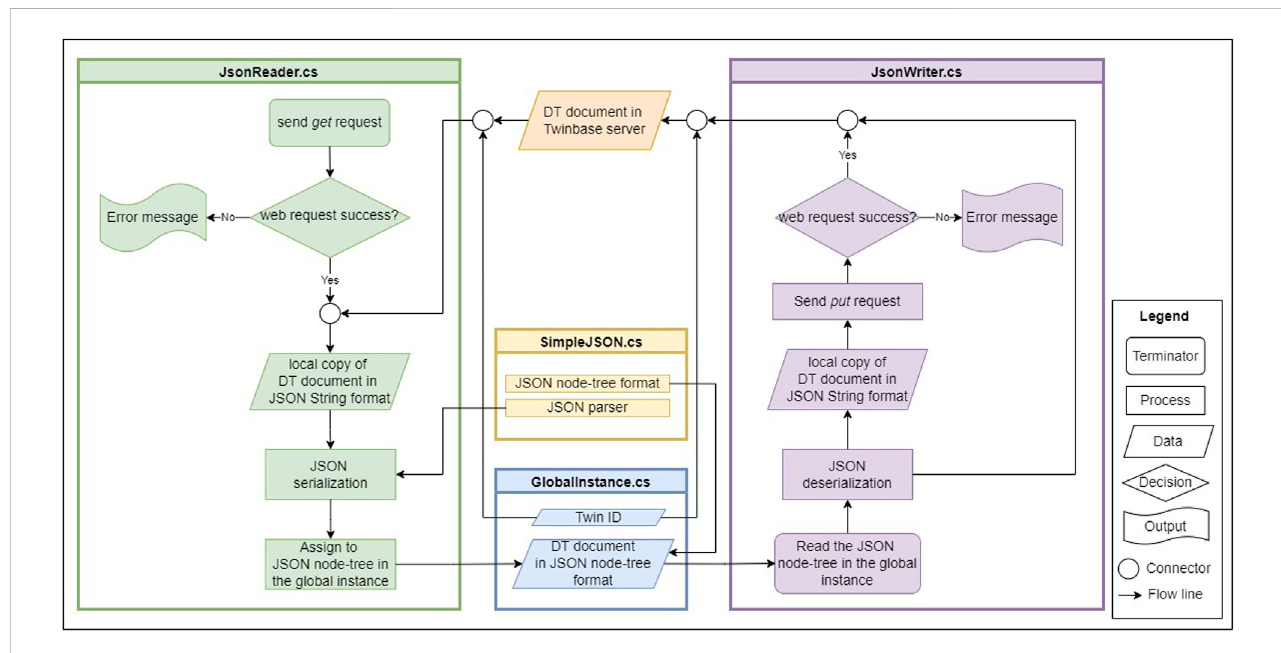
FIGURE 2 Technical desciption of the TwinXR package consisting of four scripts, namely, GlobalInstance.cs , JsonReader.cs , JsonWriter.cs , and SimpleJSON.cs